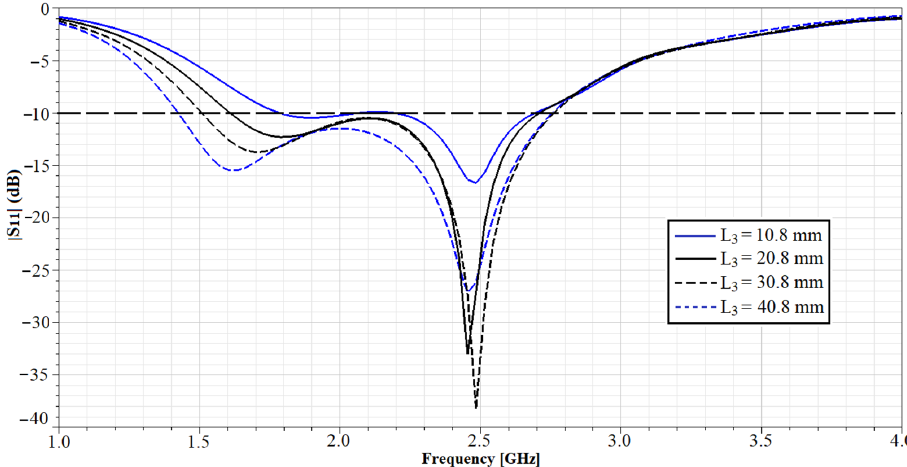
11 | with respect to the length L 1.